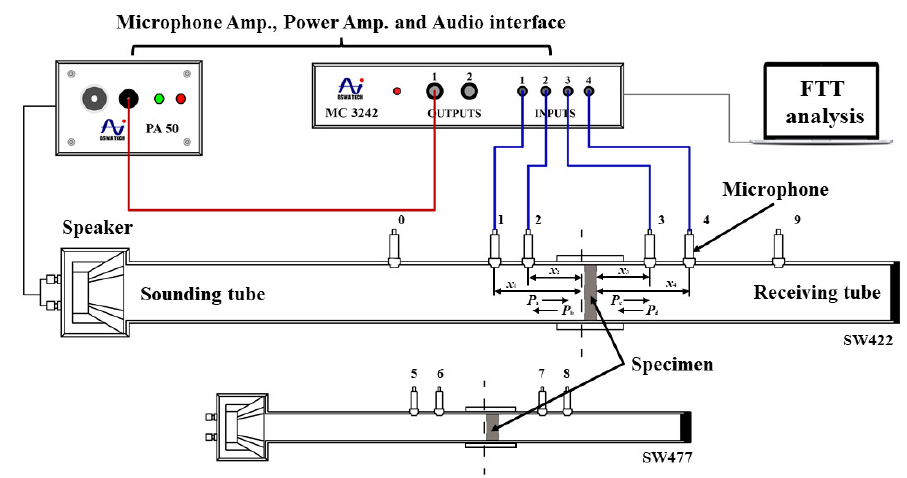
Figure 2. Four-channel sound insulation performance measurement system.